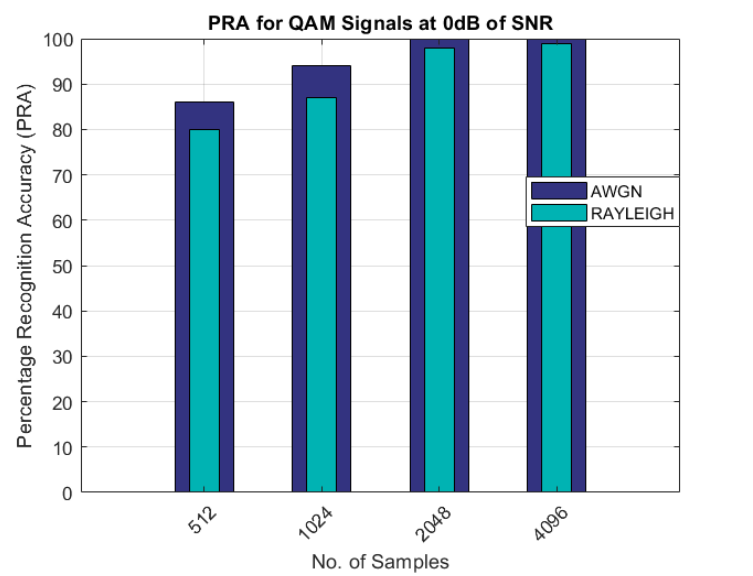
Figure 5. PRA for QAM signals.